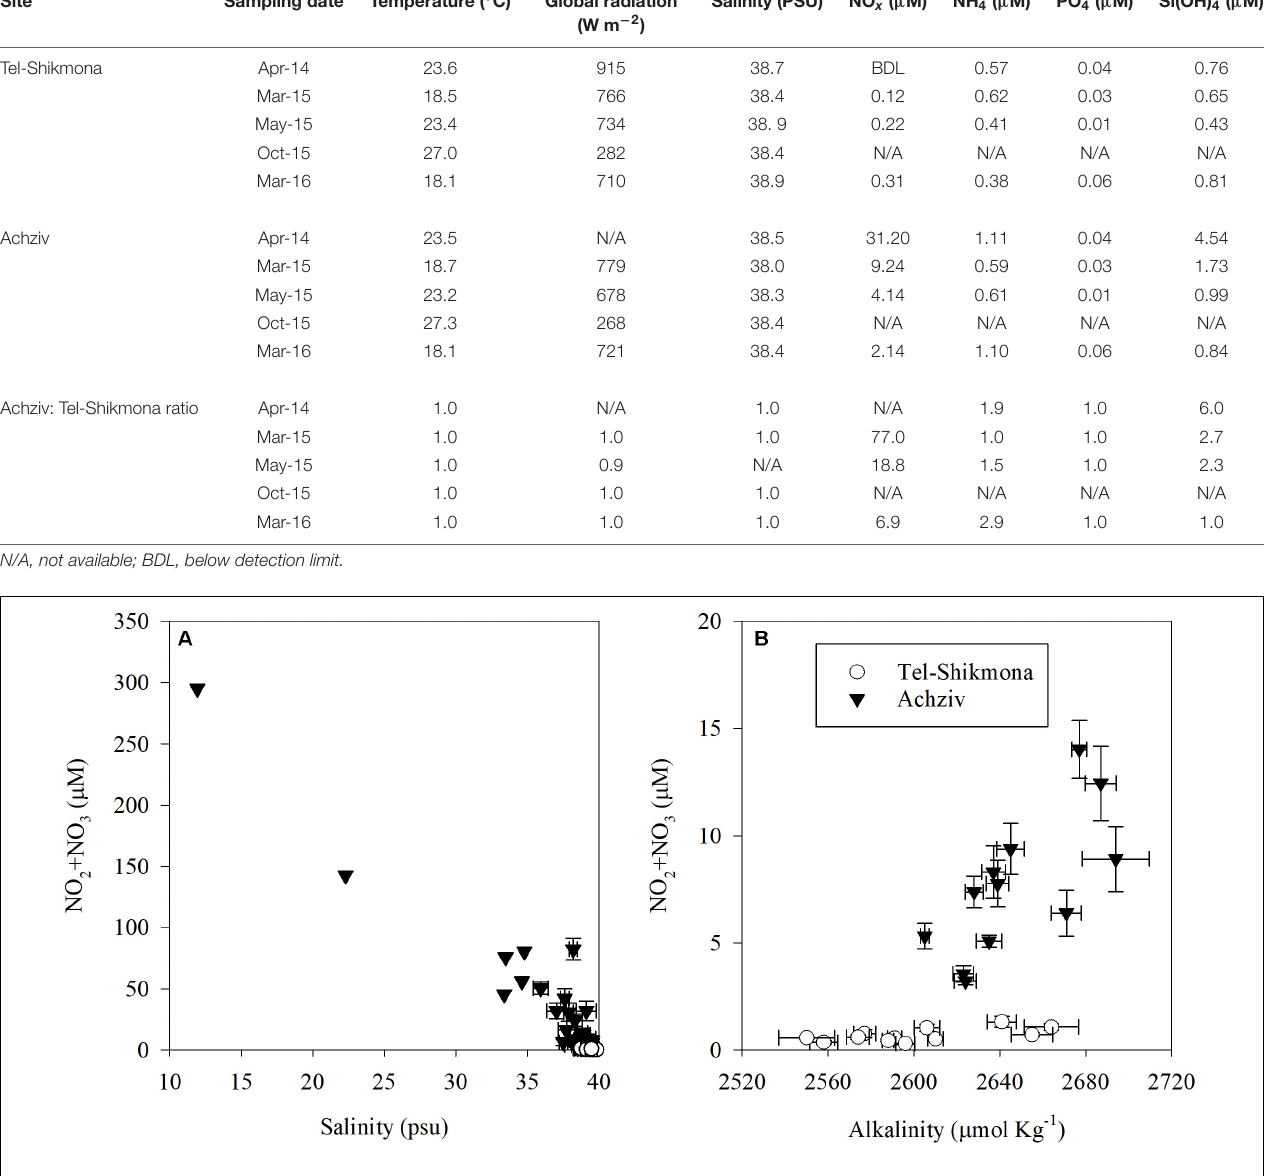
FIGURE 3 | Relationships between NO 2 + NO 3 concentrations and salinity [ R = 0.86, p < 0.01, (A) ] or total alkalinity [ R = 0.71, p < 0.01, (B) ] at a shoreline location in Achziv (black triangle) and Tel-Shikmona (while circle). Values presented in panel (A) show a tidal time series measured during May and June 2005, April